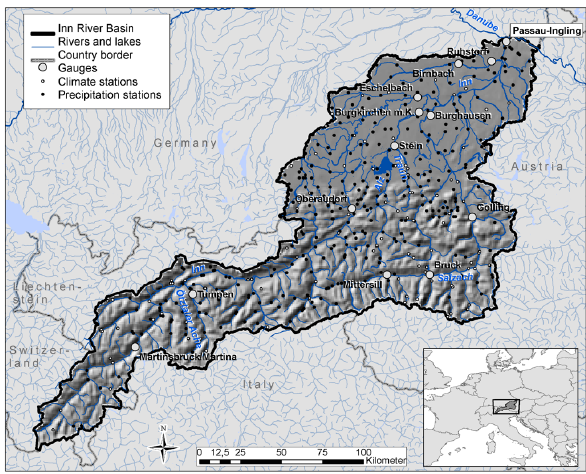
Fig. 1. Inn River basin, location of climate and precipitation stations and selected gauges.